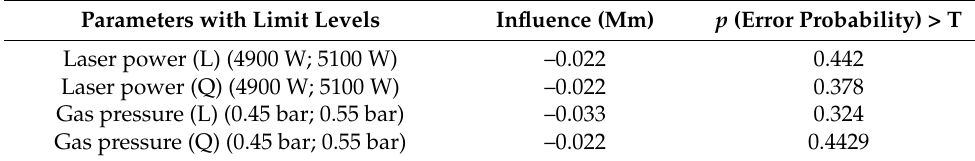
Table 8. Influence of laser power and assisting gas pressure at CO 2 laser